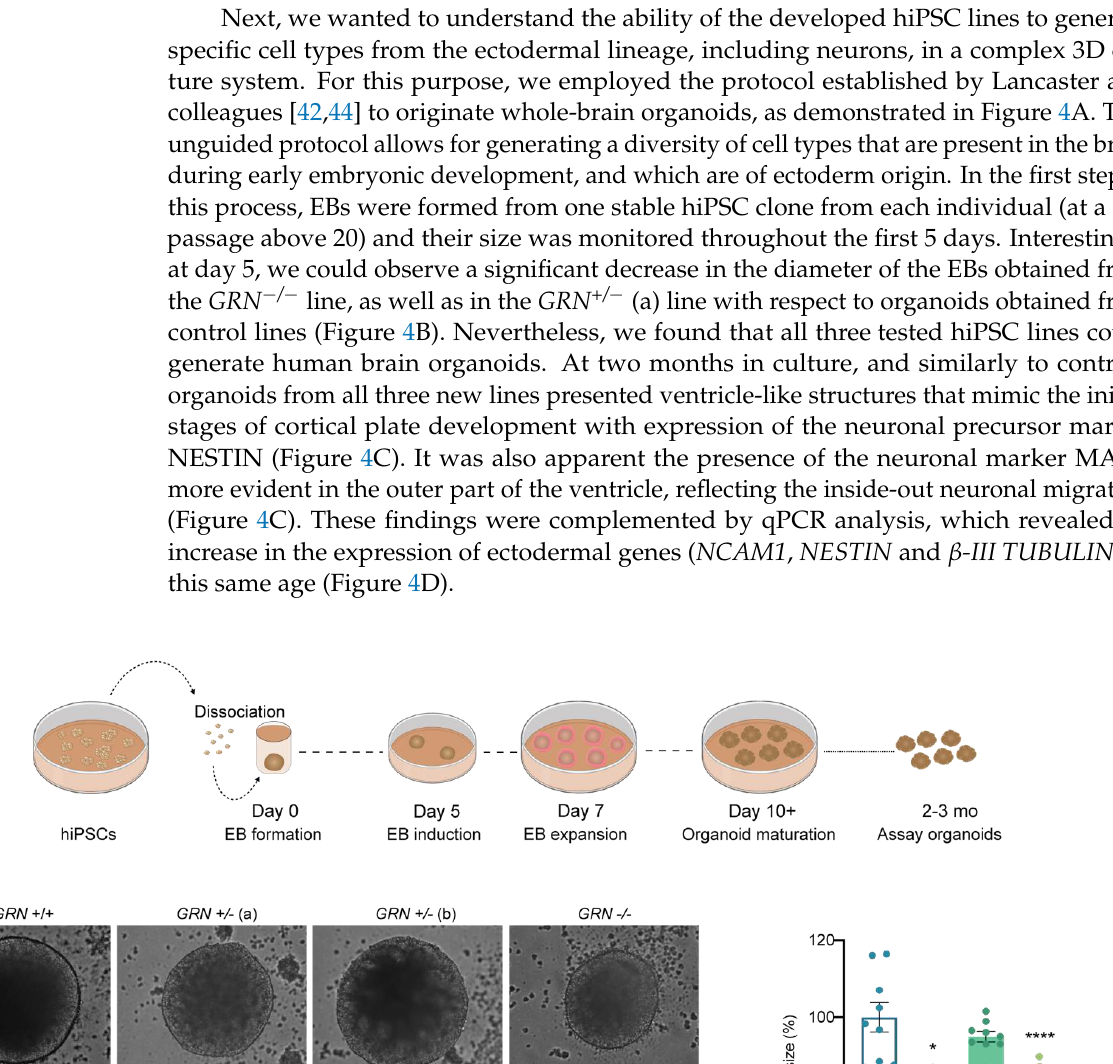
Figure 4. FTLD patient-derived hiPSCs are capable of generating brain organoids. One colony of each newly established hiPSC lines was used to generate human 3D brain models (NCBL1.c5; NCBL2.c46; NCBL3.c6 and NCBL4.c27). ( A ) Schematic representation of the organoid generation, following the protocol established by Lancaster and colleagues. ( B ) EBs size was determined at day 5 of the protocol and is presented as a % of control genotype (n = at least 3 organoids per gen- otype). EBs from GRN +/ −− (a) and GRN − / − genotypes show a decrease in mean size. ( C ) The neu- ronal precursor NESTIN and neuronal marker MAP2 are expressed in 2-month-old generated brain organoids, as observed by immunohistochemistry. ( D ) Increased expression of ectodermal genes ( NESTIN ,  III-TUBULIN , NCAM1 ) was also observed in the generated brain organoids with respect to hiPSCs (n = at least 3 organoids per genotype). ( E ) Representative Western blot mem- brane and quantification of PGRN in 3-month-old total extracts of whole-brain organoids (n = 3 organoids per genotype), normalized to GAPDH, shows a reduction in protein levels of PGRN in